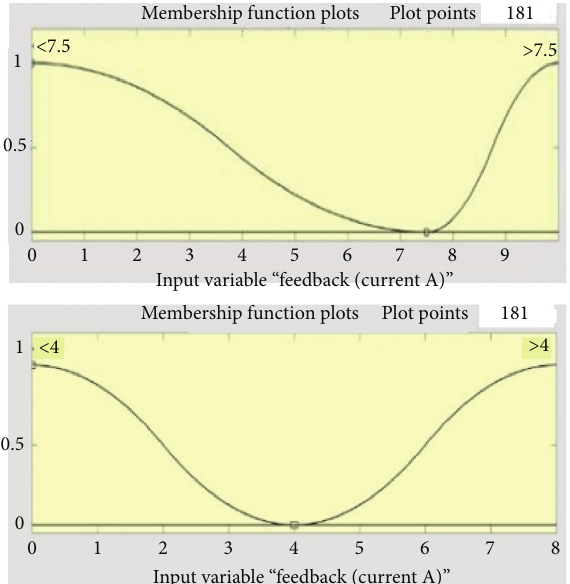
Figure 6: Input membership function for feedback.